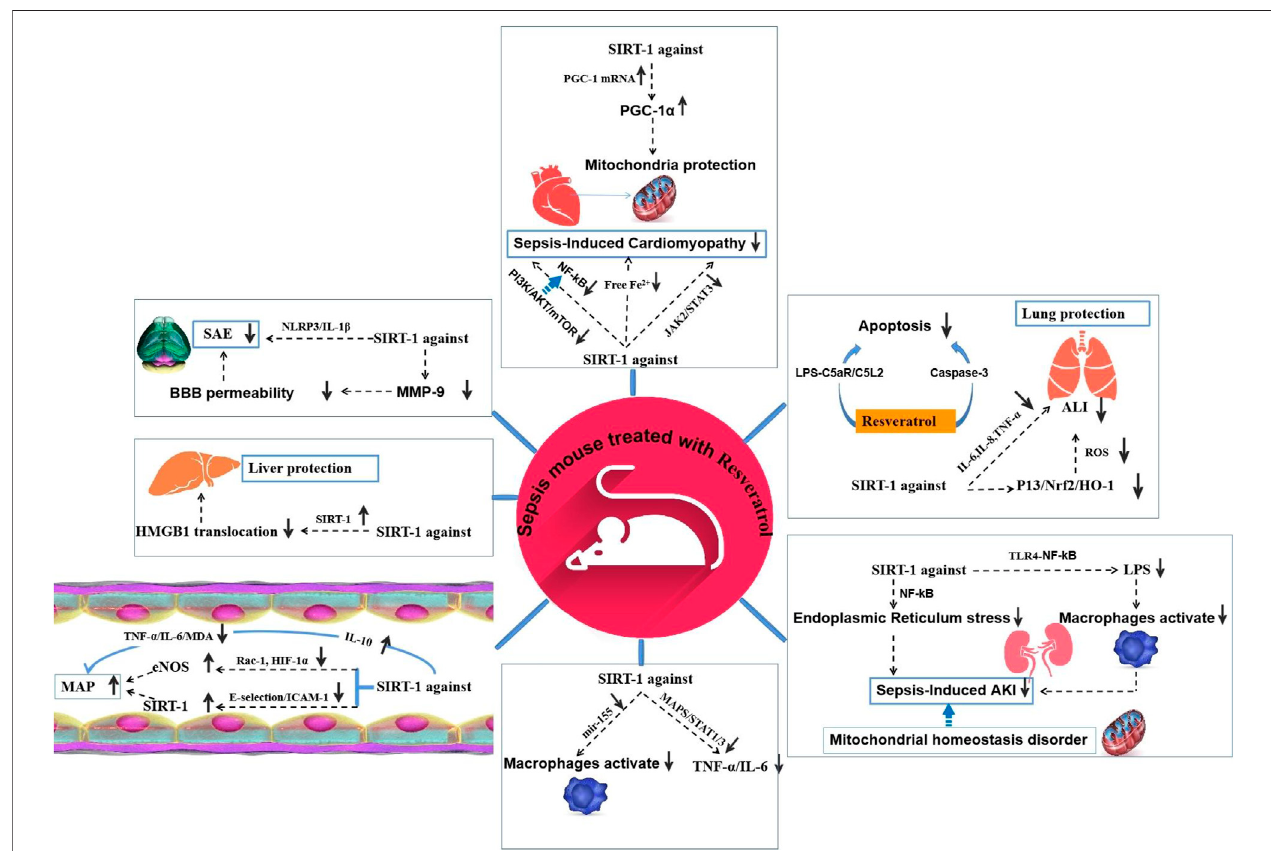
FIGURE 1 | Effection of Resveratrol on different organs of sepsis models.